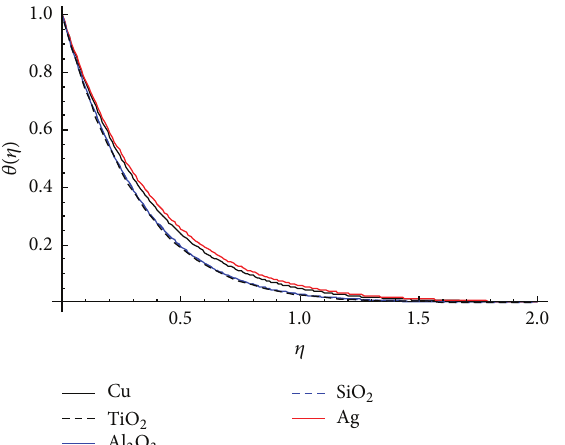
Figure 17: Comparing the variation of temperature distribution 𝜃(𝜂) for the investigated nanoparticles when 𝑃𝑟 = 6.2 , 𝛿 1 = 1 , 𝛿 2 = −1 , 𝑠 = 0.5 , and 𝜙 = 0.1 .